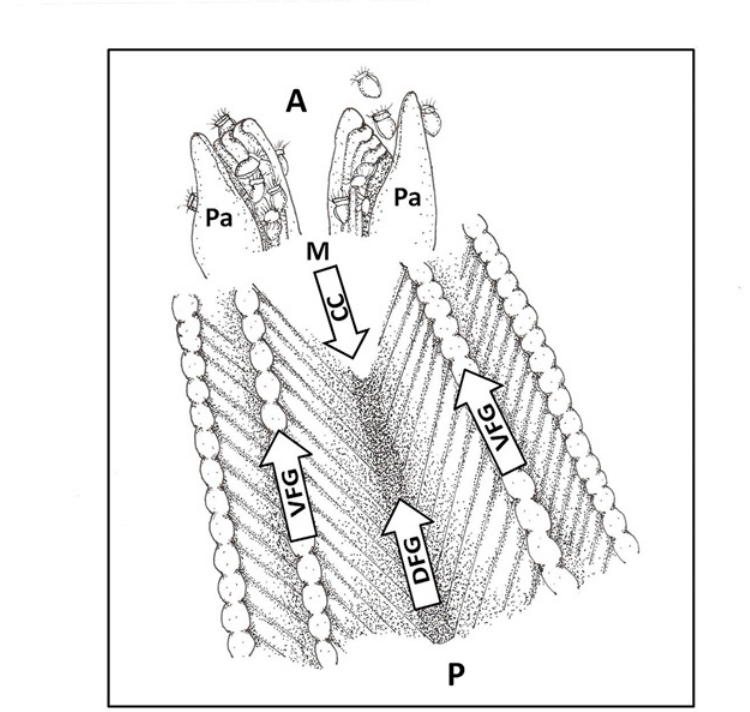
Fig 1. Ostrea chilensis. Diagram of the pallial cavity of a brooding female. Note the veligers that have accumulated near the female palps. A: anterior, CC: countercurrent, DFG: dorsal food groove, M: mouth, P: posterior, Pa: female palps, VFG: ventral food